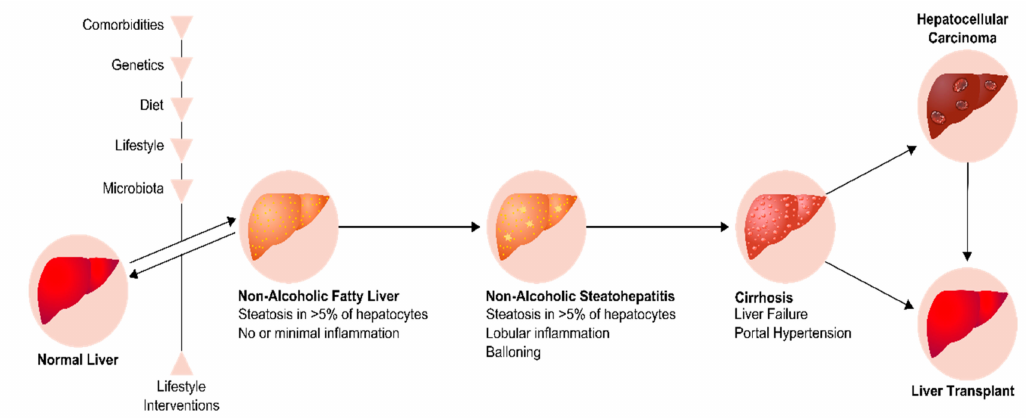
Figure 2. Progression of Non-Alcoholic Fatty Liver Disease. The liver begins to accumulate fat due to erratic lifestyle habits, genetics, microbiota and comorbidities leading to Non-Alcoholic fatty liver. It can then progress to Non-Alcoholic Steatohepatitis (NASH) or be reverted through lifestyle interventions. NASH is characterized by lobular inflammation and ballooning. In some cases, it can progress to cirrhosis. This is a severe stage than can lead to the development of hepatocellular carcinoma (HCC), ending up in the need of liver